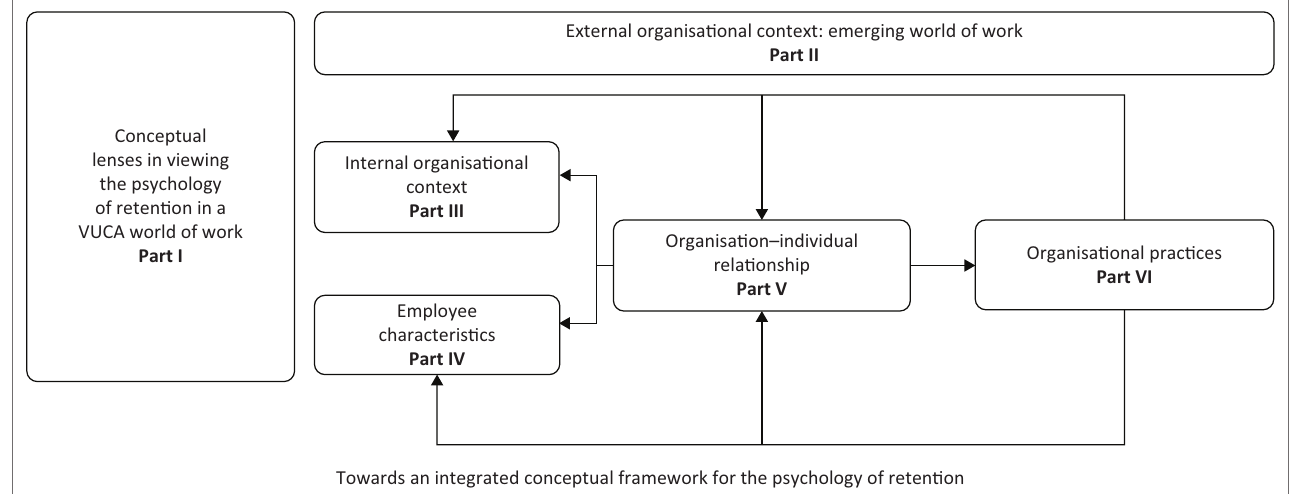
FIGURE 1: Coetzee et al.’s (2018) conceptual framework for the psychology of retention in a world of volatility, uncertainty, complexity and ambiguity (VUCA).